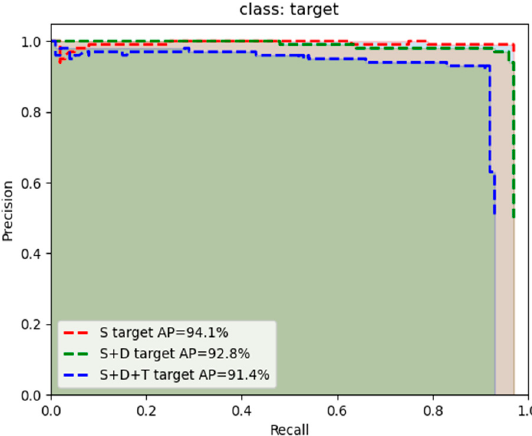
Figure 11. P–R curves and the corresponding AP values.